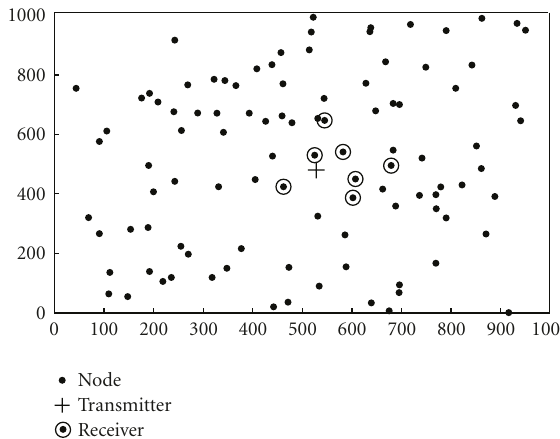
Figure 2: Example of simulation grid, density = 1 node per 100 × 100m 2 .